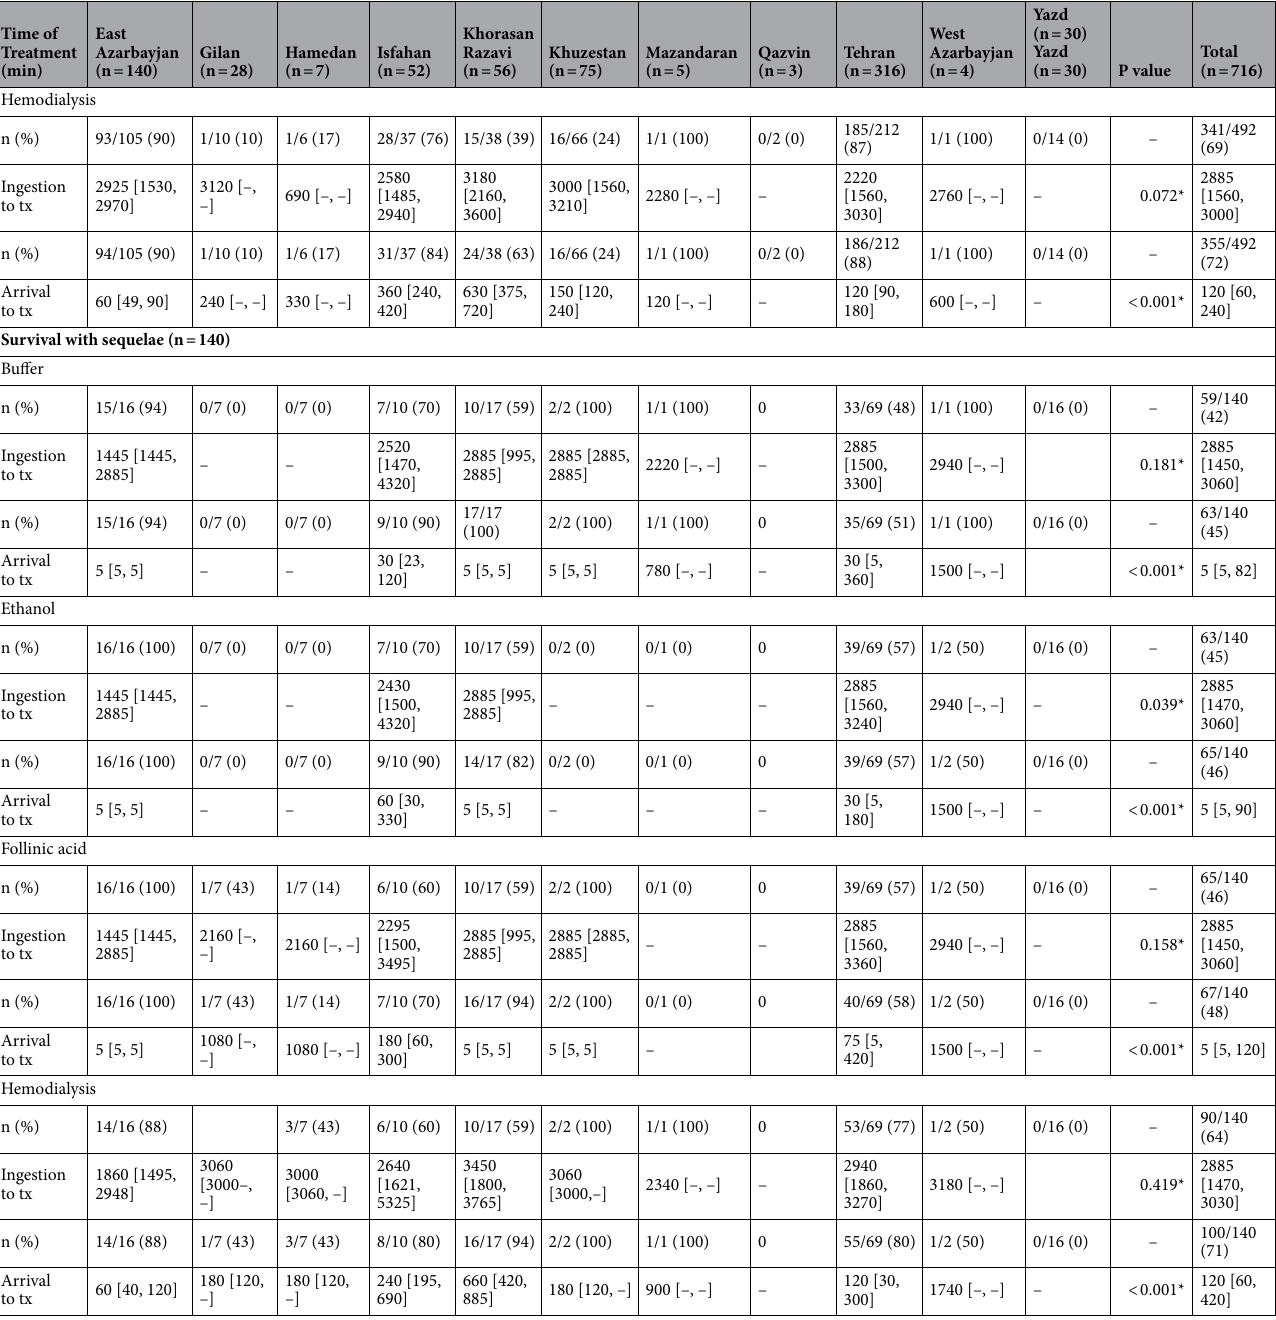
Table 4. Median [interquartile range] time of treatments in three major outcomes of 13 toxicology referral centers during early Iranian methanol outbreak. ND not defined, missing data treated by random. *Applying Kruskal Wallis test. † applying Pearson Chi–Square. ‡ Applying Man–Whitney